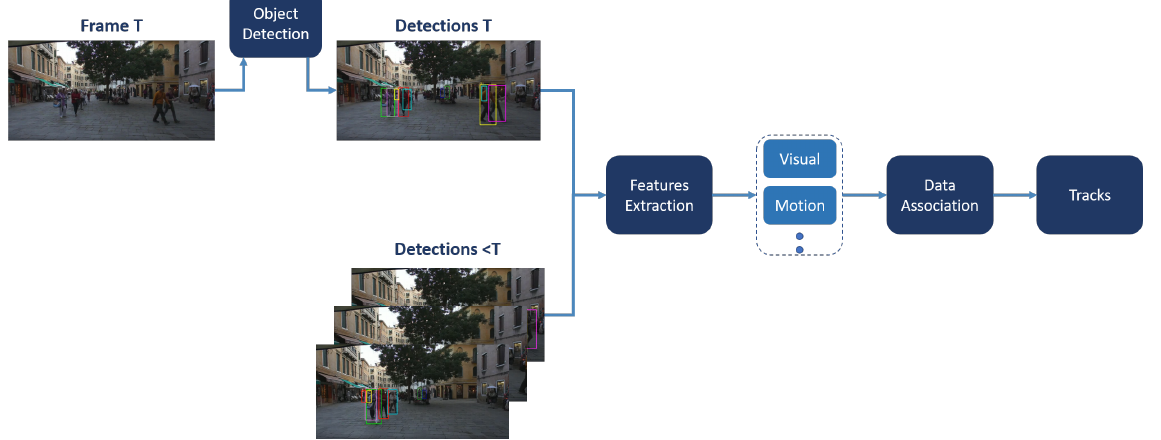
Figure 1. General framework of MOT systems. Visual and motion features of the detected objects at frame T are extracted and compared to those detected from previous frames. A robust data association algorithm would be able to match the features of the same objects. The final output of the system would be tracked with unique IDs identifying the multiple objects detected and tracked over the multiple